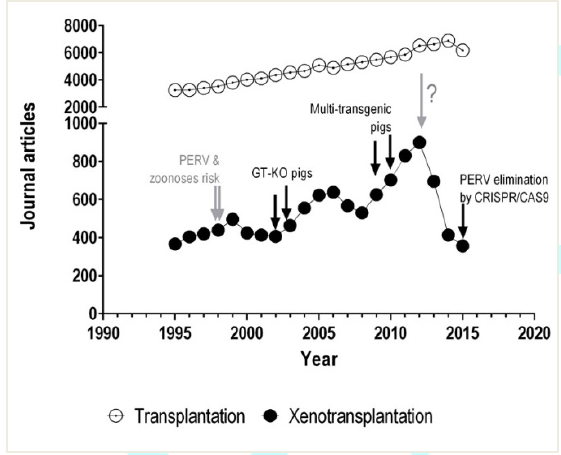
Figure 2: Chronology of the numbers of peer-reviewed publications in the field of xenotransplantation. A PubMed search of original articles for the term "xenotransplantation" excluding (AND NOT) "tumor" was done for the years between 1995 and 2015 (●). The exclusion criterion was aimed to remove studies in which human tumour cells were injected into other animals, a model commonly used in cancer research. As control, "transplan- tation" AND NOT "tumor" search was also performed (○). Grey arrows indicate probable events that negatively impacted the field of xenotransplan- tation, whereas black arrows represent potentially positive impacts. CRISPR/Cas9 = clustered regularly interspaced short palindromic repeats and the associated protein 9; GT-KO = α1,3-galactosyltransferase knock- out; PERV = porcine endogenous